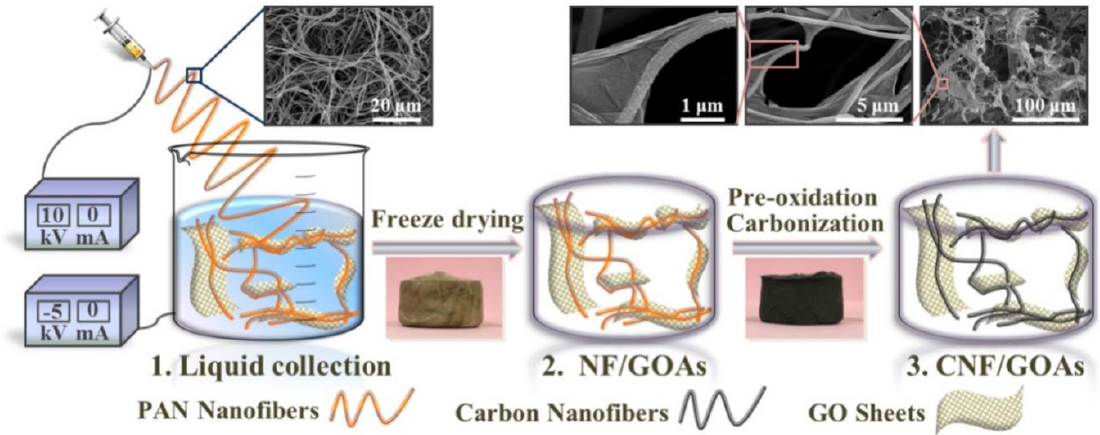
Figure 10. Electrospinning polyacrylonitrile (PAN) polymer nanofiber in graphene oxide (GO) solution to make carbon nanofiber/GO aerogel. Reproduced under the terms and conditions of the